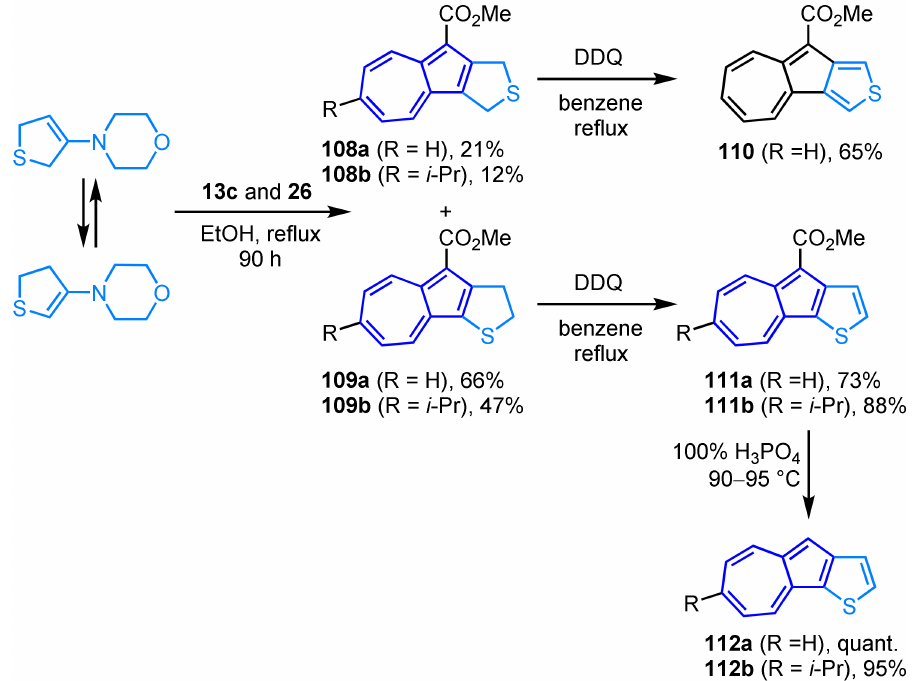
Scheme 29. Synthesis of azuleno[1,2- c ]- and azuleno[1,2- b ]thiophenes 110 , 111a , b , and 112a , b . A similar pathway to the synthesis of azulenothiophenes has been adapted for the preparation of azulenopyrroles and furans 117 – 122 (Scheme 30) [60]. The reaction of the enamines, which are obtained by condensation of N -ethoxycarbonyl-3-oxopyrrolidine or 3-oxotetrahydrofuran with morpholine, with 13c gives dihydroazulenopyrroles or furans 113 – 116 after seven days in refluxing ethanol. Azuleno[1,2- b ]pyrrole and furan 118 and 119 can be obtained in 99 and 86% yields, respectively, by the aromatization of the corre- sponding dihydro derivatives 115 and 116 with DDQ. When 113 is treated with manganese dioxide in benzene, azuleno[1,2- c ]pyrrole 117 is formed in 37% yield, while the corre- sponding furan derivative 114 does not show the aromatization under the similar reaction conditions. When 118 is treated in 100% H 3 PO 4 at 90 ◦ C, decarboxylation occurs only on the azulene ring to afford 120 in 95% yield, whereas by further increasing the reaction temperature (180 ◦ C), the decarboxylation of the ester group on the nitrogen takes place to provide azuleno[1,2- b ]pyrrole 122 in 97% yield. When a similar reaction is applied to 119 at 90–95 ◦ C, azuleno[1,2- b ]furan 121 is obtained in 46% yield. Azuleno[1,2- b ]furan and pyrrole 121 and 122 suggested a slight decrease in the aromaticity of these compounds compared to that of the parent azulene, since the coupling constants of these derivatives in 1 H NMR spectra show a distinct bond-length alternation at the seven-membered